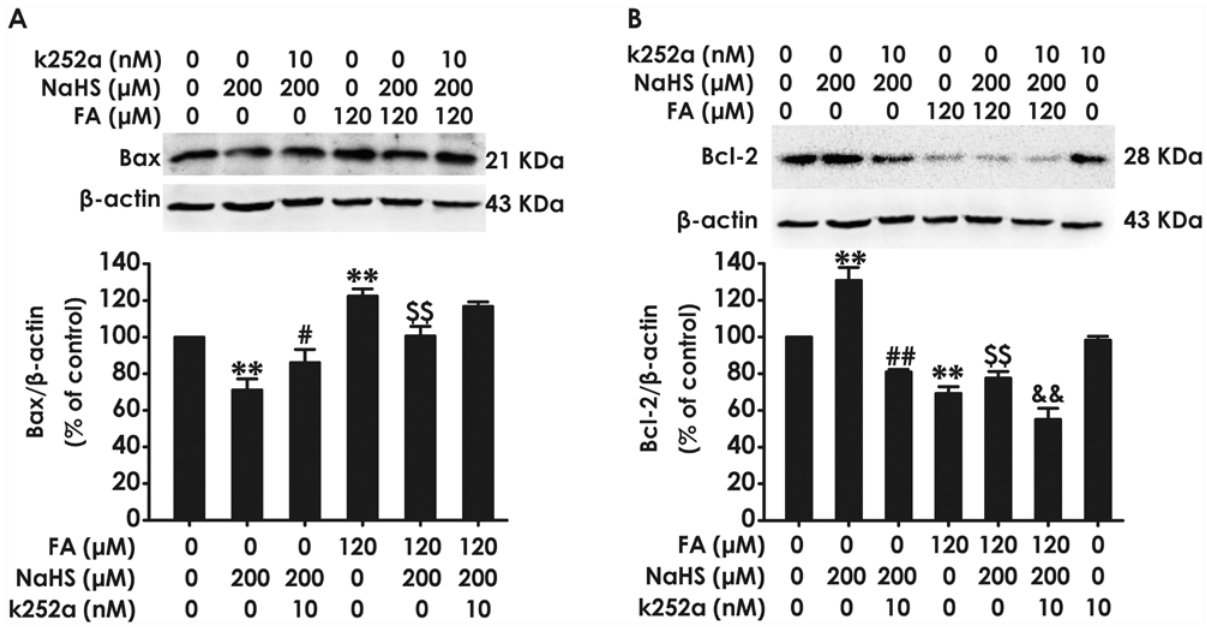
Fig 6. Effect of K252a on H 2 S-caused suppression in formaldehyde-induced upregulation of Bax and downregulation of Bcl-2 in PC12 cells. PC12 cells were pre-incubated with K252a (10 nM) for 30 min before pretreatment with NaHS (200 μ M) for 30 min prior and the cotreated with formaldehyde (FA, 120 μ M) for 24 h. The expression of Bax (A) and Bcl-2 (B) were detected by Western blot using anti-Bax antibody and anti-Bcl-2 antibody, respectively. In all blots, β -actin was used as a loading control. The ratio of Bax or Bcl-2 to β -actin was normalized by the value in control group. Values were expressed as the mean ± S.E.M. of three independent experiments. ** P < 0.01, versus control group; ## P < 0.01, versus NaHS-treated alone group; $$ P < 0.01, versus FA- treated alone group; && P < 0.01, versus cotreated with NaHS and FA